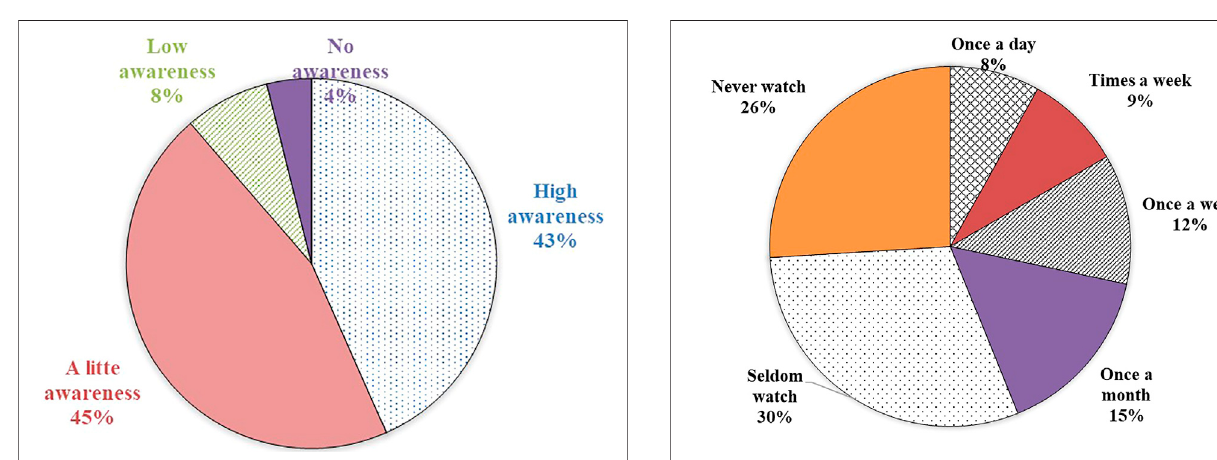
FIGURE 7 | Respondents ’ attitude toward ZEHs ’ value considering energy saving and emission reduction.